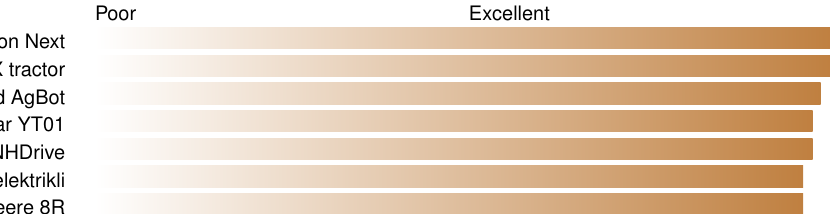
Figure 11. MIM overall evaluation: tool & attachments and availability & price KPIs.